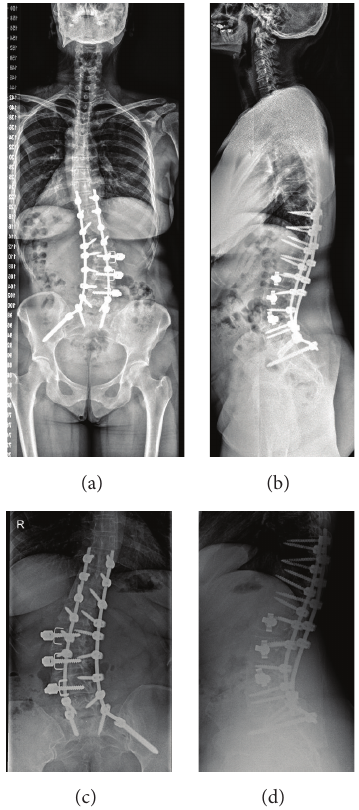
Figure 4: (a-b) Anterior and lateral spinal views with definitive instrumentation T-10 to iliac bone. (c-d) Lumbar X-ray